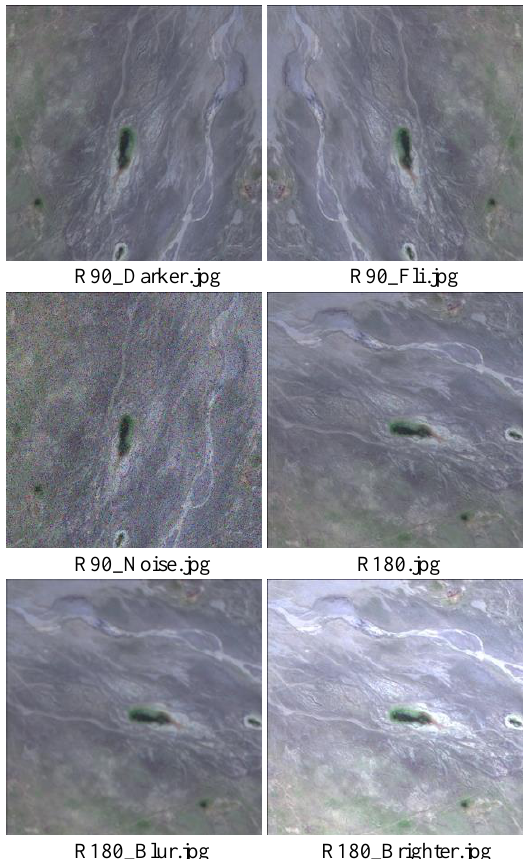
Figure 4. Partial results of data enhancement with a single JPG